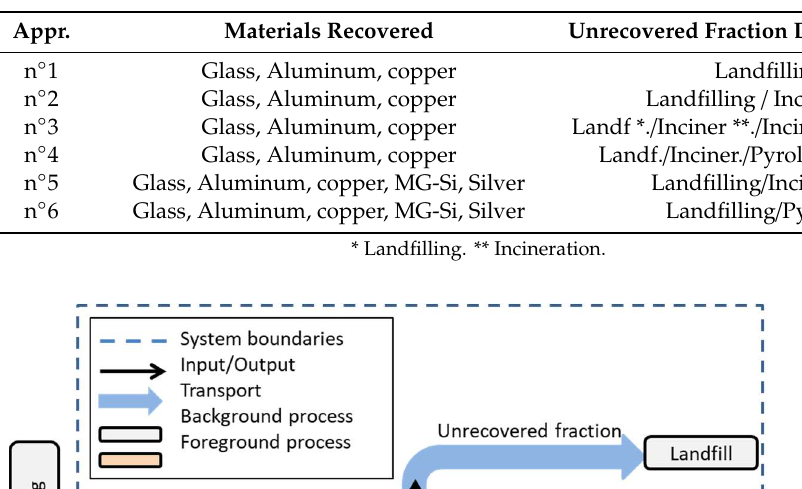
Table 3. Modelled approaches and respective features.